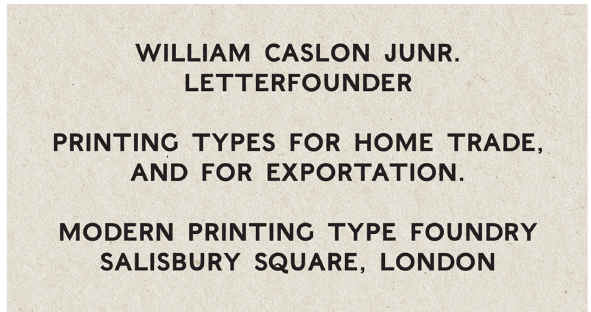
Figure 3. The typeface ‘English Egyptian’ by William Caslon Junior,